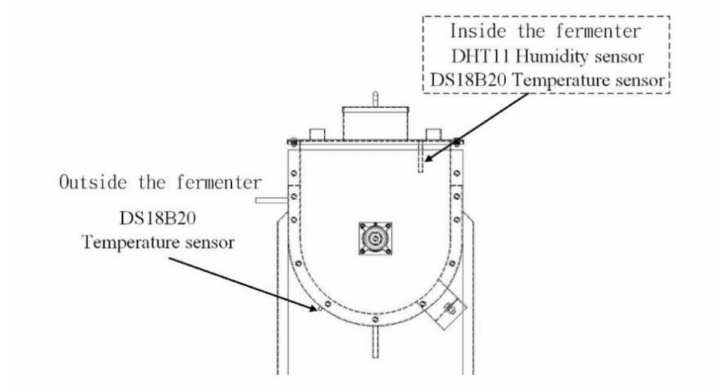
Figure 6. Fermentation barrel temperature sensor placement diagram.